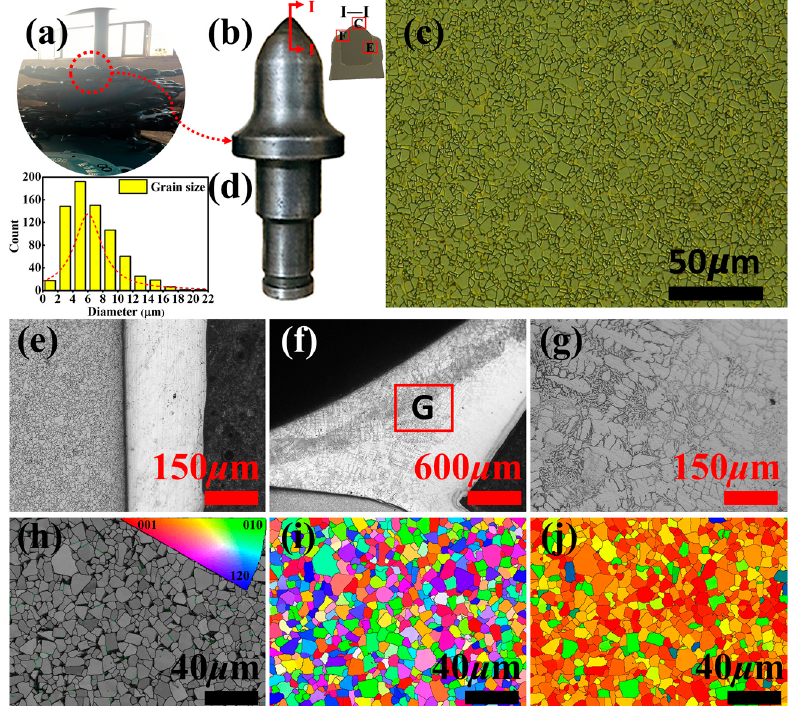
Figure 2. Joint design and example of brazing of WC–Co cemented carbide and steel. ( a ) Digging machine. ( b ) Drag pick. The joint geometry is shown in the top-right corner. ( c ) Microstructures of WC–Co cemented carbide (region “C” in Figure 2b). ( d ) Coincidence site lattice (CSL) grain boundaries. WC–Co / Cu–Ag / 9SiCr joint ( e ) in region “E”, ( f ) in region “F” in Figure 2b, and ( g ) in the fusion zone in region “G” in Figure 2f. ( h ) Electron back-scattered di ff raction (EBSD) pattern; the top-right corner shows the crystal preferred orientation. ( i ) EBSD orientation maps of heat-a ff ected WC–Co. Step size: 150 nm. The colored areas are binders and tungsten carbides; different colors indicate different orientations (Euler angles) and grains. ( j ) Smith factor.